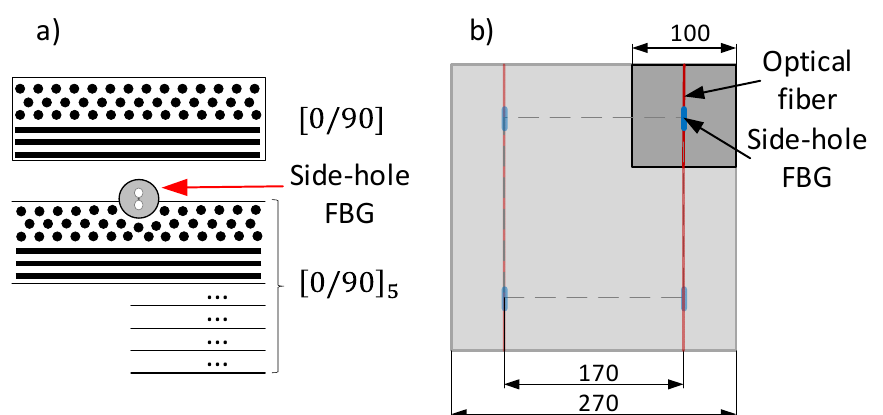
Figure 9. The scheme of composite samples with placed HiBi FBG sensors. ( a ) Stacking of layers and side-hole FBG placement; ( b ) Location of samples in the manufactured plate.